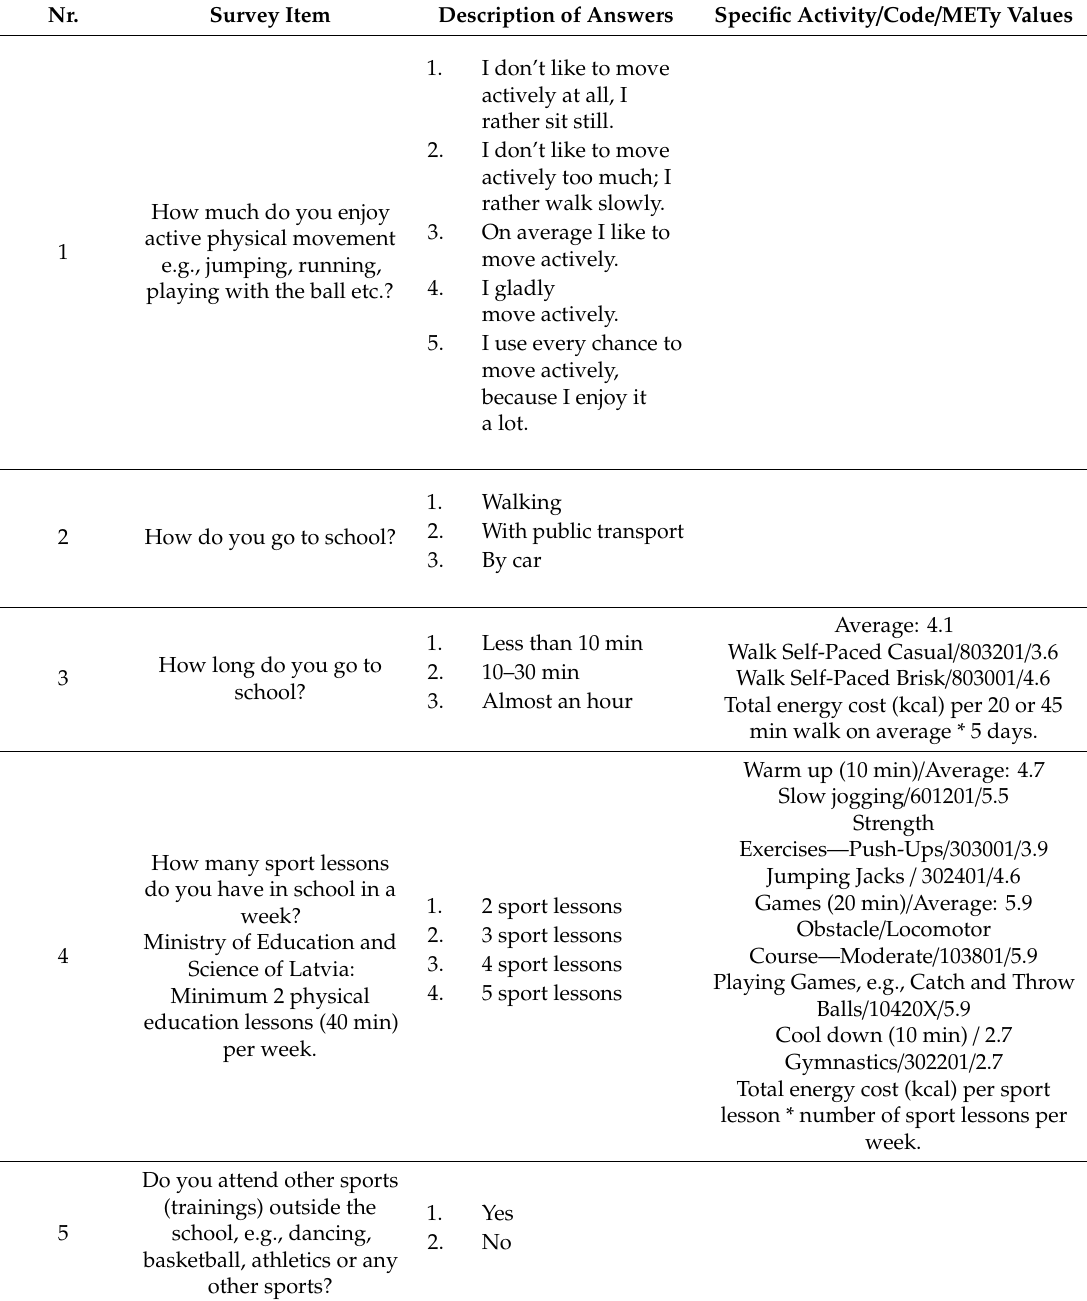
Table A2. Estimation of structured physical activity levels on weekdays based on youth compendium of physical activity